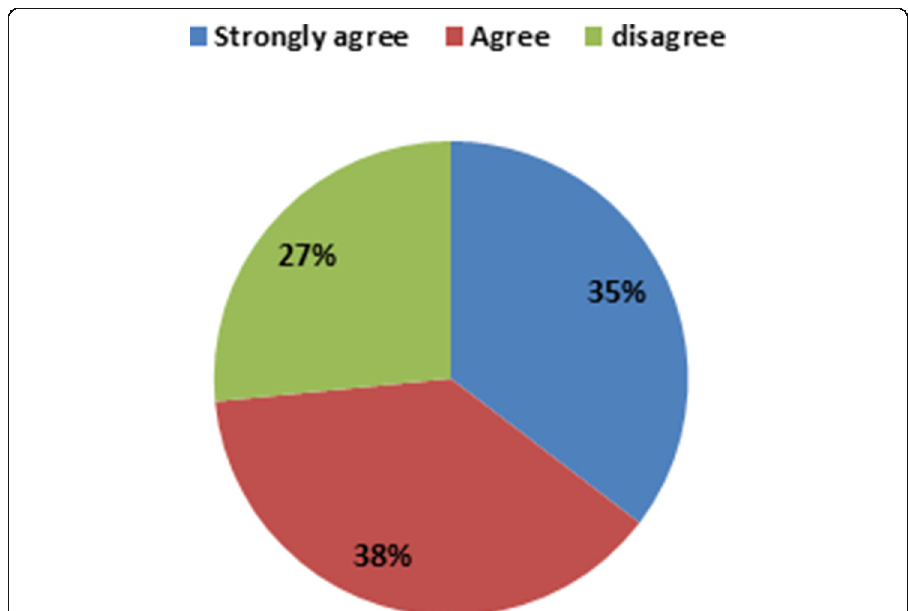
Fig. 3 Perception of participants towards OER